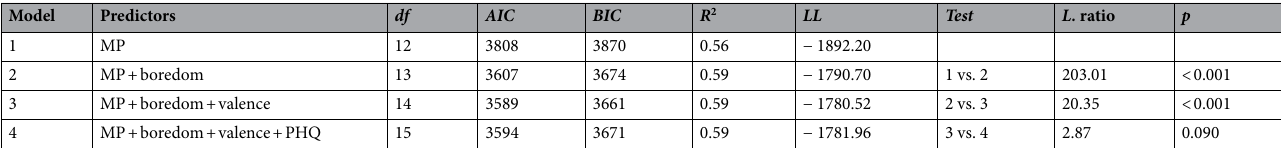
Table 3. Stepwise regression. In a stepwise manner, the pandemic boredom ratings, valence ratings and PHQ scores are added to the model predicting the pandemic PPT from the measurement points (MP) of the main study. For the statistical model comparisons, the degrees of freedom (df), Akaike information criteria (AIC) and Bayesian information criteria (BIC), R 2 , Log-Likelihood (LL), log-likelihood ratio (L. Ratio) and p-values are